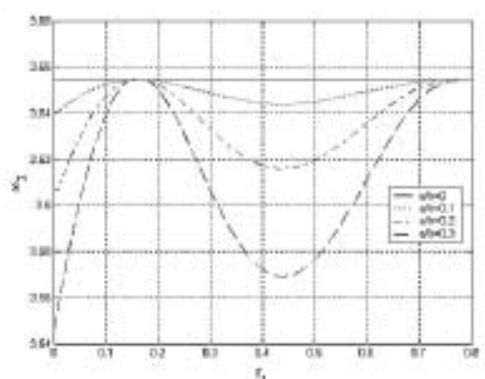
Fig. 7. The second structural frequency parameter of the coupled system as a function of the position of the crack. The fluid is considered to be compressible with